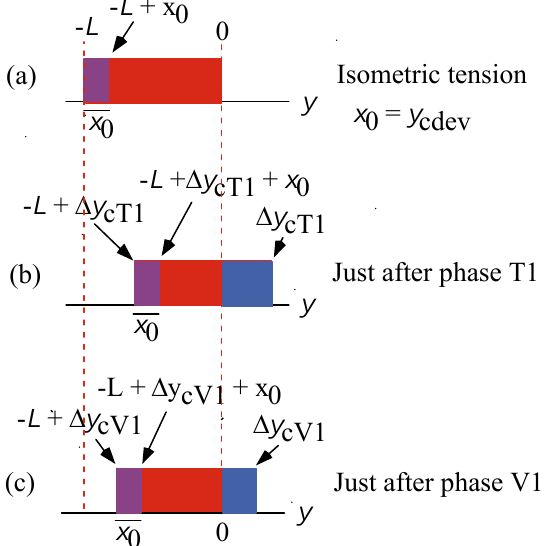
Figure 10. The  distributions before and after instantaneous changes in the isometric tension transient and in the isotonic velocity transient. (a) The isometric tetanus state; ( b ) Just after Phase T1 in the isometric tension transient; (c) Just after Phase V1 in the isotonic velocity transient for the same length change as (b)